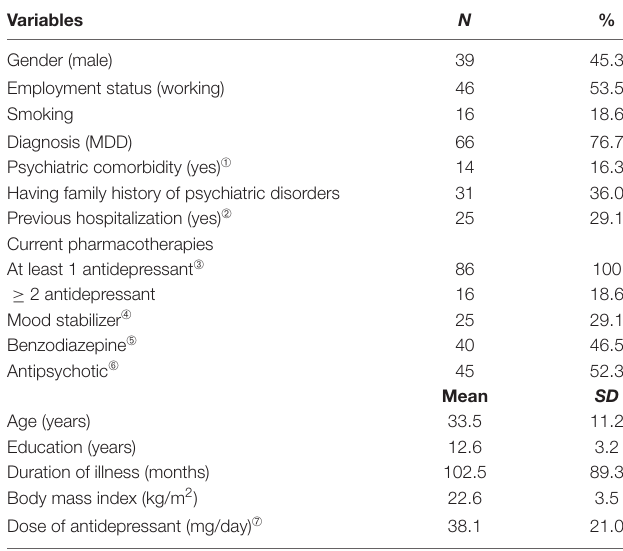
TABLE 1 | Baseline demographic characteristics of patients ( n =